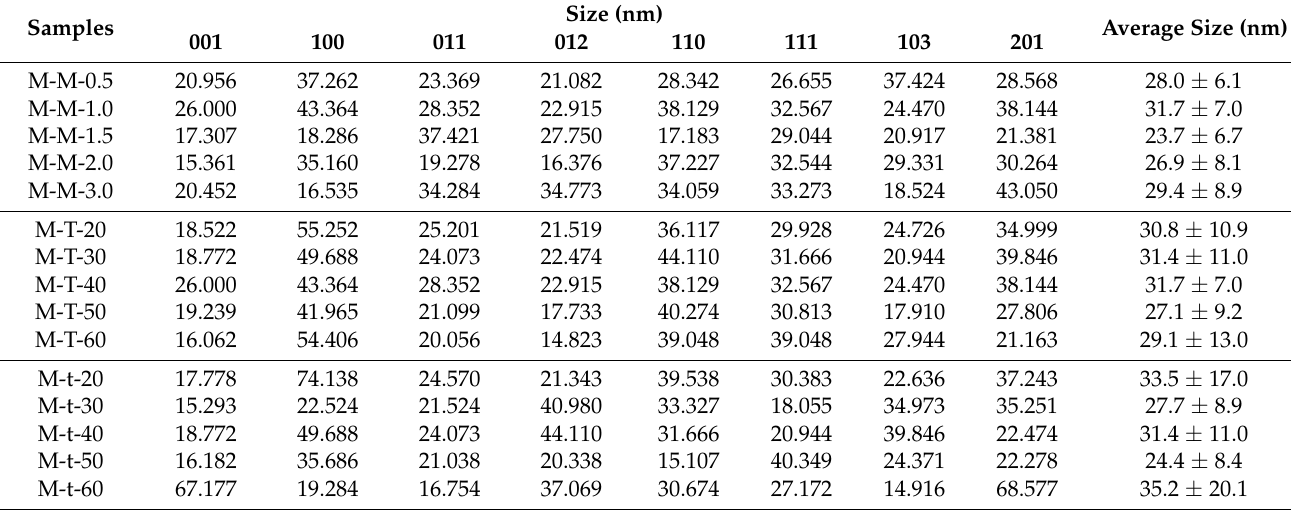
Table 3. The XRD parameters and grain size of the synthetic nano-Mg(OH) 2